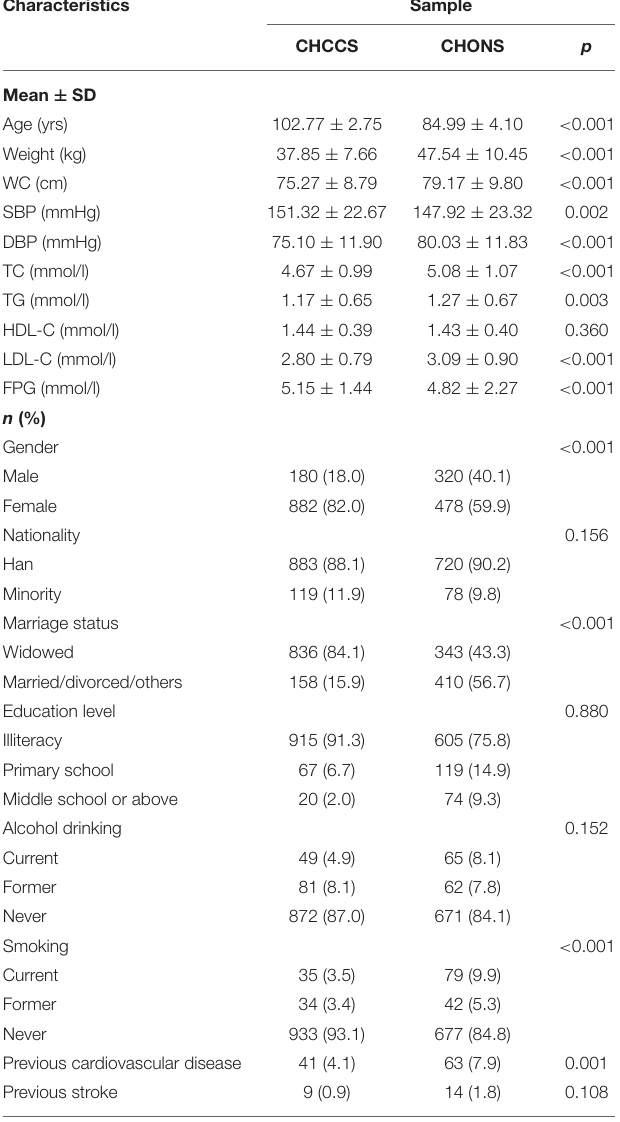
TABLE 1 | General characteristics of